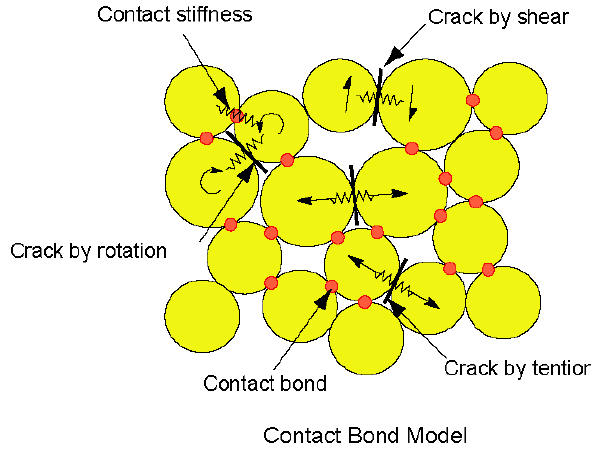
Figure 4. Illustration of bond models provided in PFC (Particle Flow Code) [16].